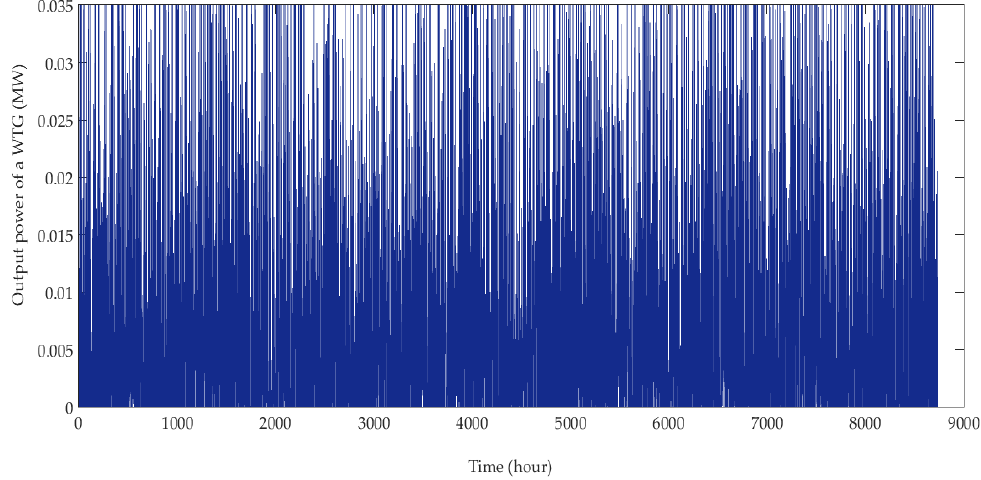
Figure 8. Simulation of the output power from WTG for the sampling year.